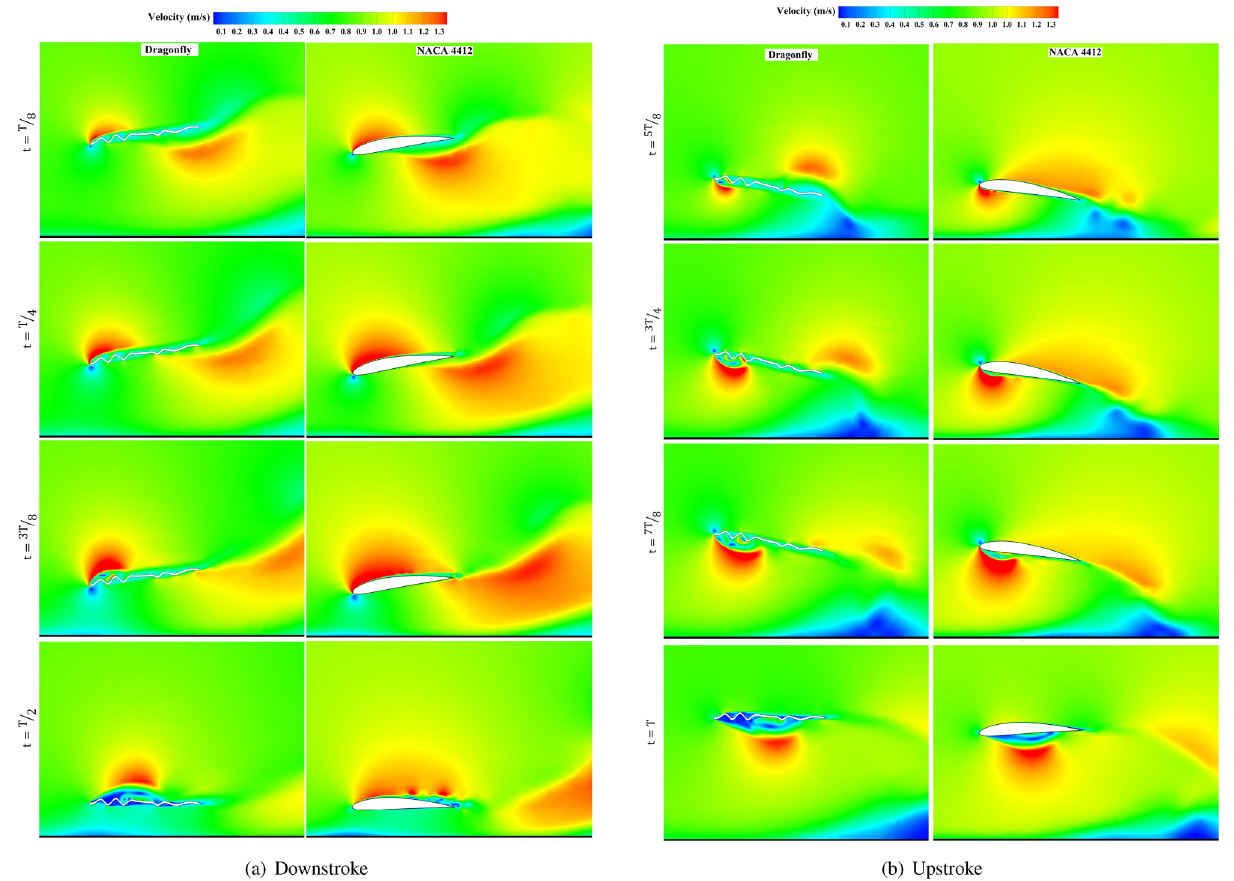
4 and St =0.6 for both